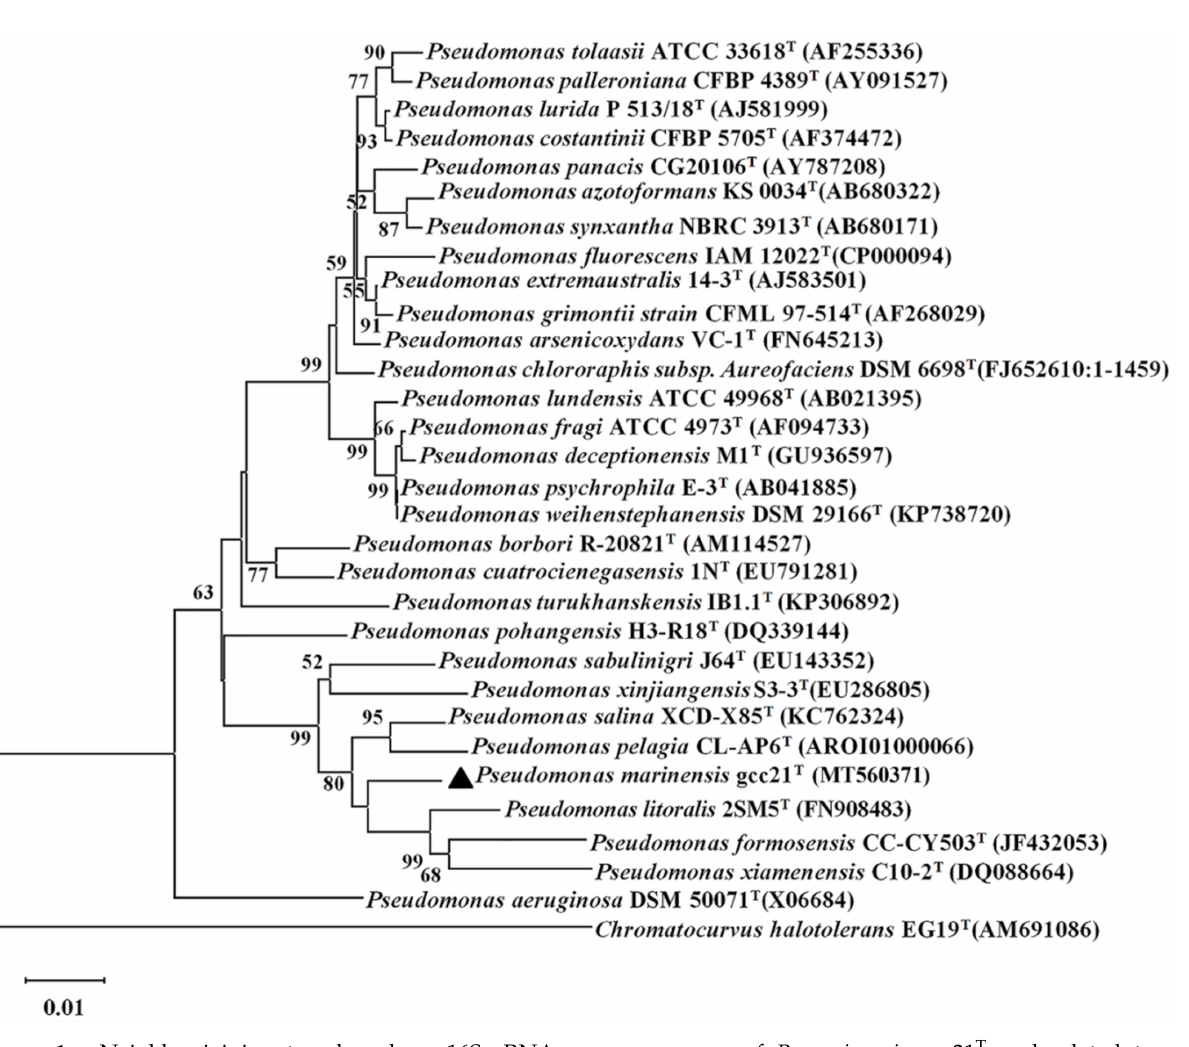
Figure 1. Neighbor-joining tree based on 16S rRNA gene sequences of P. marinensis gcc21 T and related taxa. The black triangle represents the evolutionary position of P. marinensis gcc21 T . The 16S rRNA sequence of Chromatocurvus halotolerans EG19 T was used as an outgroup. Bootstrap values at nodes were derived from 1000 replicates. Only bootstrap values higher than 50% are shown. Bar, 0.01 substitutions per nucleotide